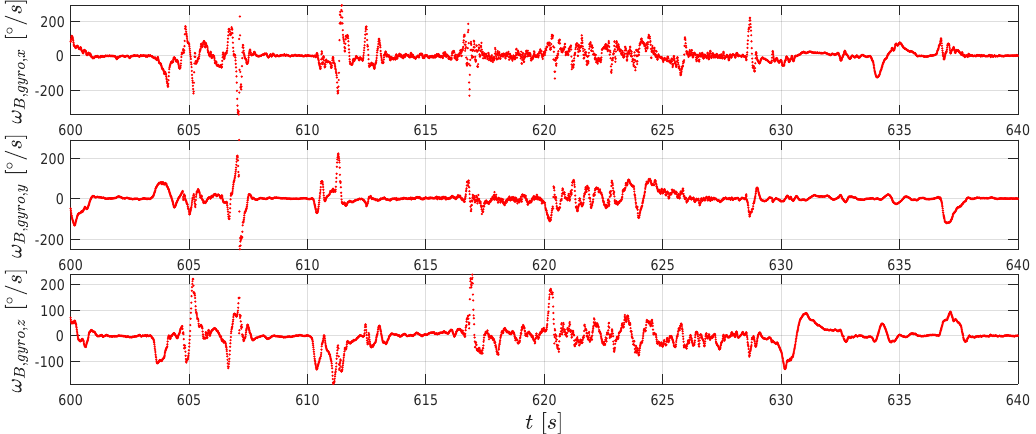
Figure 13. The gyroscope measurements ω B, gyro (red